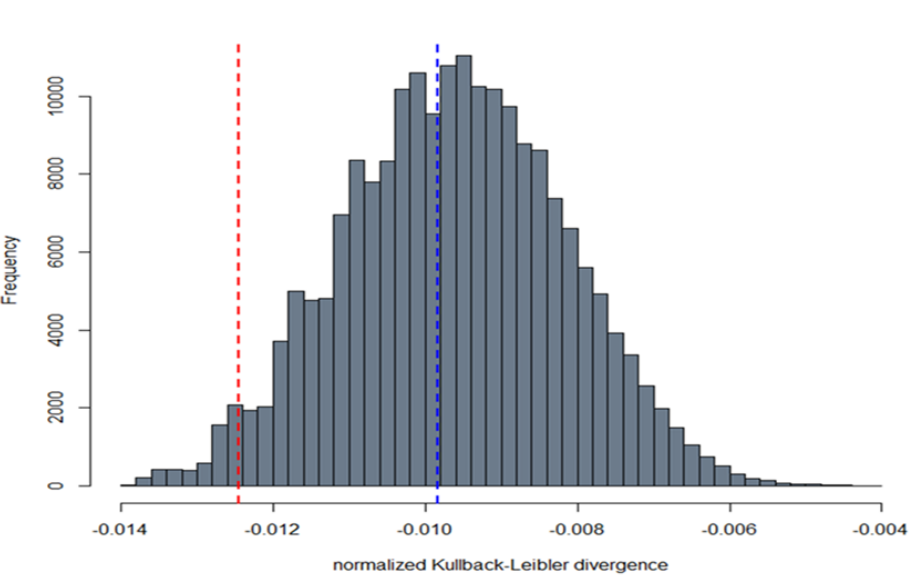
Figure 7. Bootstrap distribution of the Kullback–Leibler divergence. The histogram shows the distribution of the normalised Kullback–Leibler divergences evaluated via the bootstrap method. The nKLD between the original MNT and PNT was −0.0098 (blue dotted line). The MNT and PNT data were re-sampled with replacement 100,000 times. The red dotted line shows the 5% lower-tail quantile (−0.0125) of the bootstrap distribution. Since the observed nKLD was lower (in absolute value) than the 5% lower-tail quantile, we concluded that the divergence was not significantly different from zero ( p -value = 0.44).